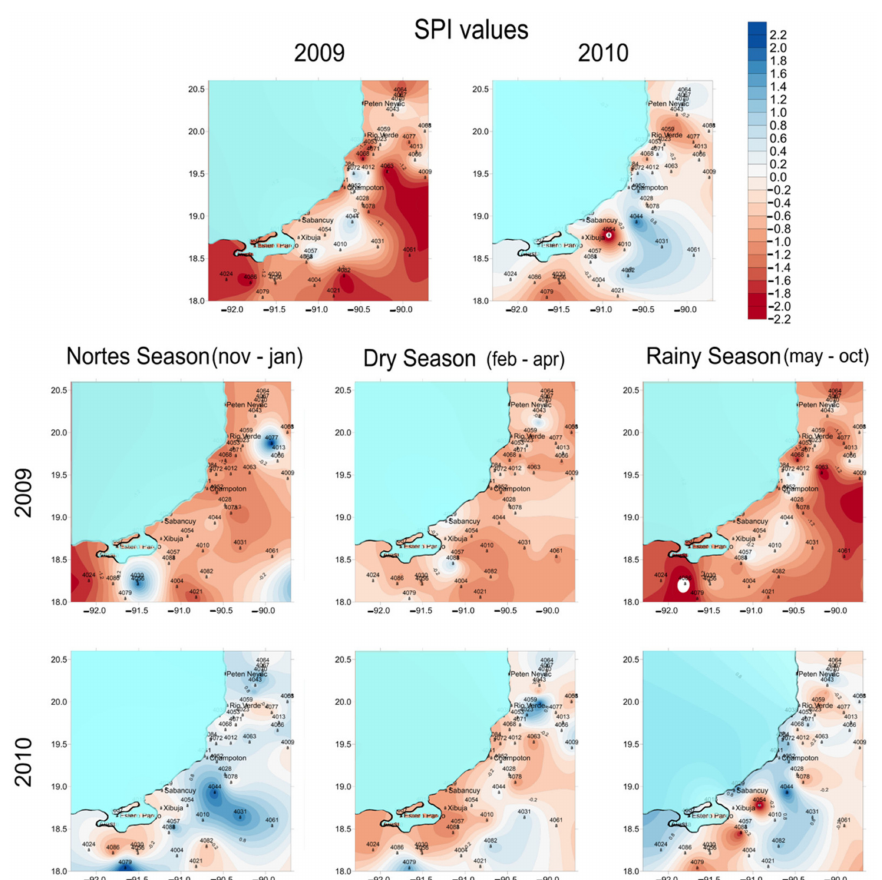
Figure 5. Standardized precipitation index (SPI) at three different times during 2009 and